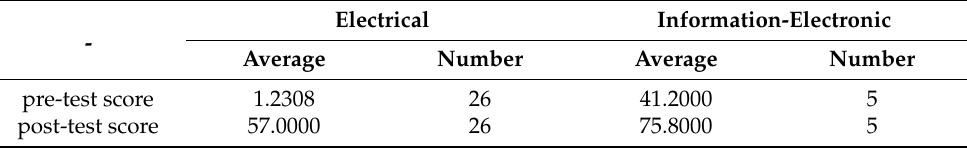
Table 5. Pre-test and post-test scores for different TVEJUEE categories in